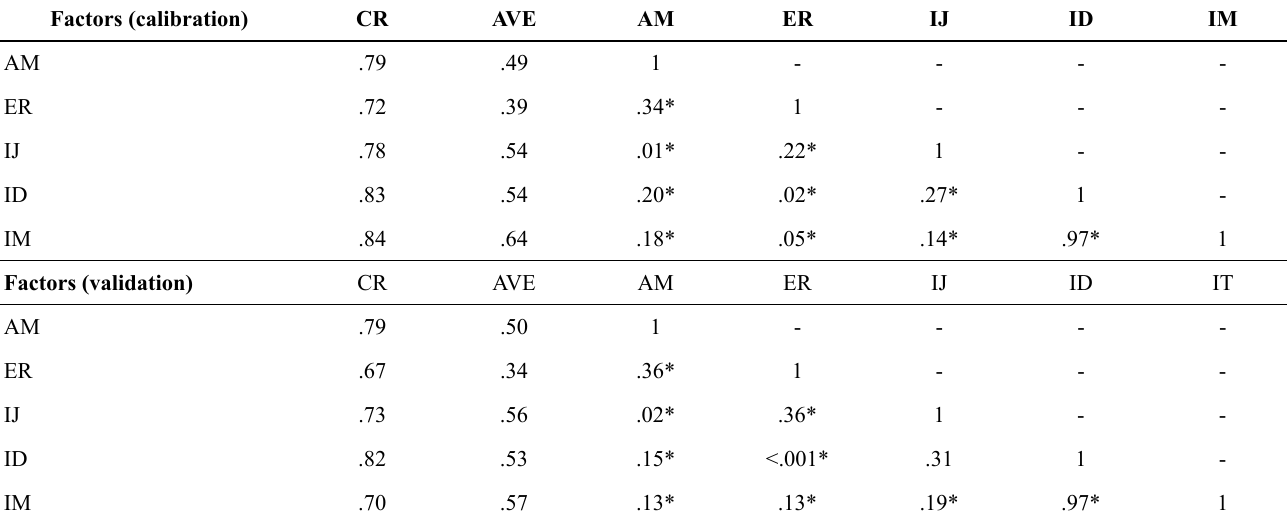
Table 3 Internal reliability, convergent and discriminant validity and average variance extracted – Calibration and Validation samples Factors (calibration)